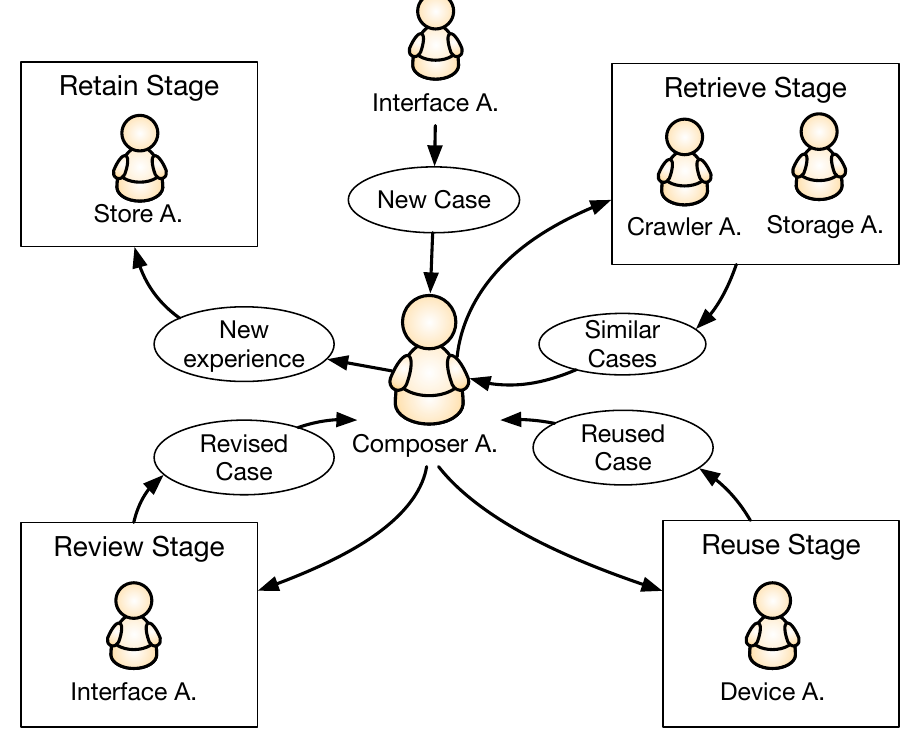
Figure 5. Schema with the CBR process. The case represents a formalization of a melody with the initial requirements submitted by the user, and the final review